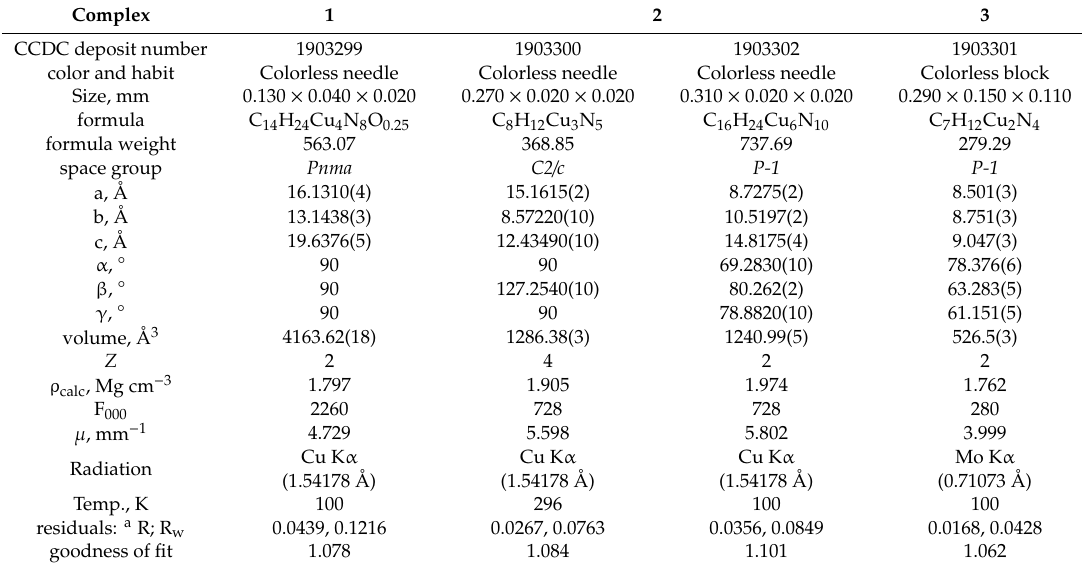
Table 1. Crystal and structure refinement data.